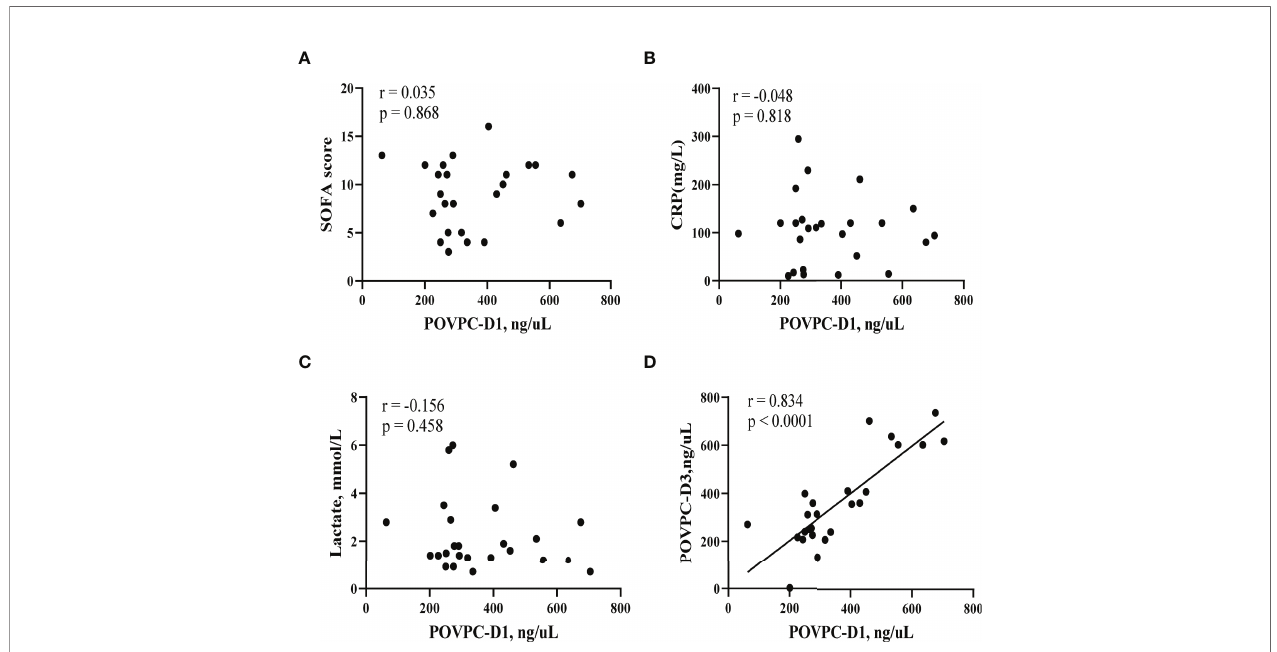
FIGURE 4 | Correlation of HDL POVPC level with SOFA score and CRP and lactate levels. Scatter diagram for (A) correlation analysis between HDL POVPC-D1 and SOFA; (B) correlation analysis between HDL POVPC-D1 and CRP; (C) correlation analysis between HDL POVPC-D1 and lactate; (D) correlation analysis between HDL POVPC-D1 and HDL POVPC-D3. POVPC, 1-palmitoyl-2-(5-oxovaleroyl)-sn-glycero-phosphatidylcholine; POVPC-D1, POVPC at Day 1; POVPC-D3, POVPC at Day 3; HDL, high-density lipoprotein; SOFA, sequential organ failure assessment; CRP, C reactive